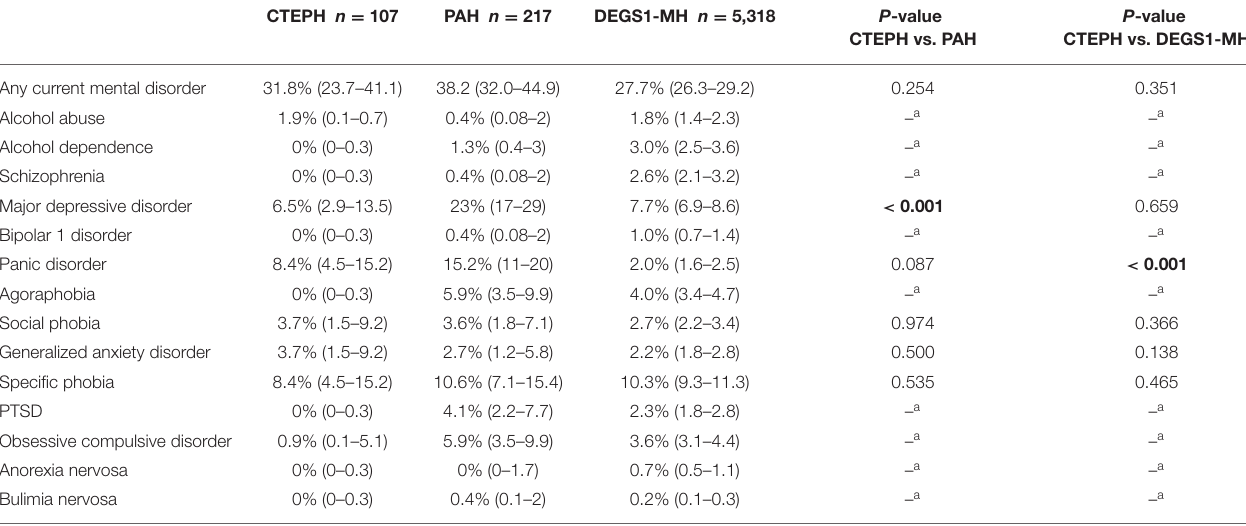
TABLE 2A | Prevalence of common mental disorders of CTEPH in comparison to data from PAH and the general German population (DEGS1-MH).